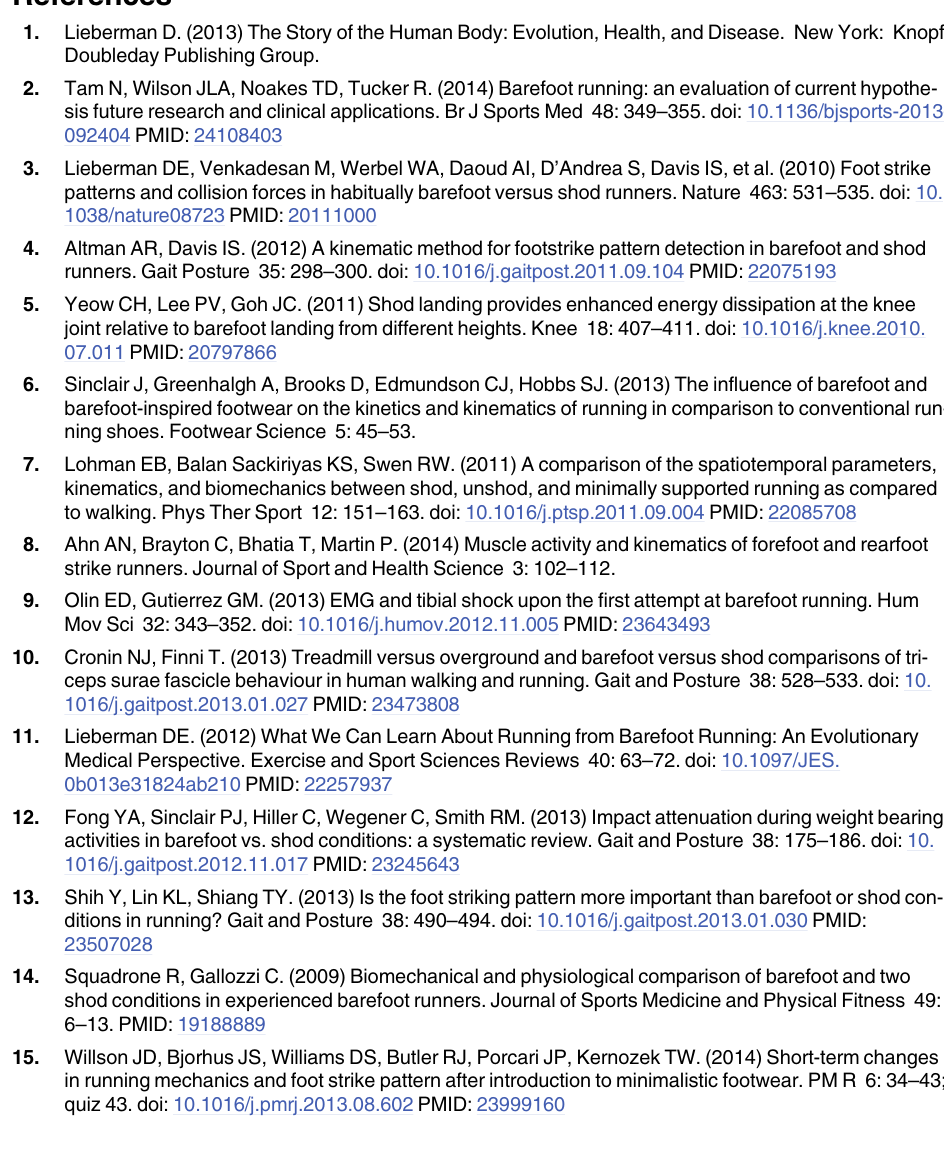
S2 Fig. Landmarks for the calculation of Hallux Angle S1 Table. The participant-level feet morphology data and other relevant information(gen- der and habitually shod or unshod